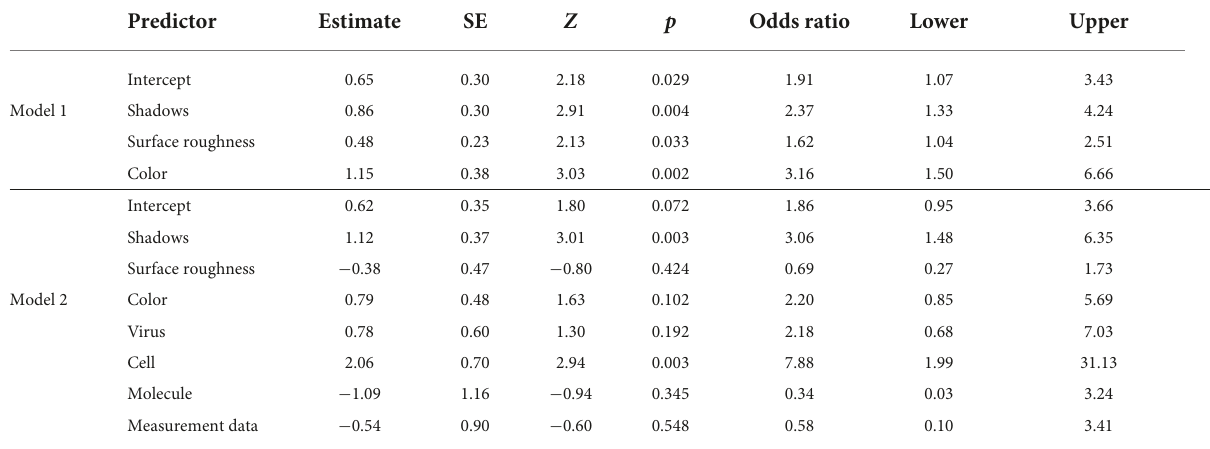
TABLE 5 Binary logistic regression analysis of participants’ desire to explore